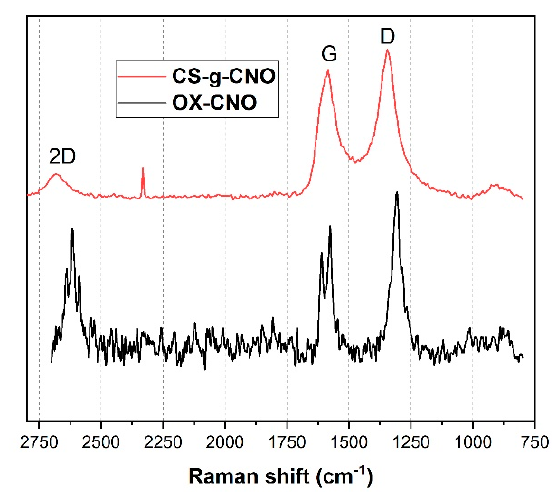
Figure 4. Raman spectrum of chitosan-grafted-carbon nano onions (red line) and oxidized carbon nano onions (black line).